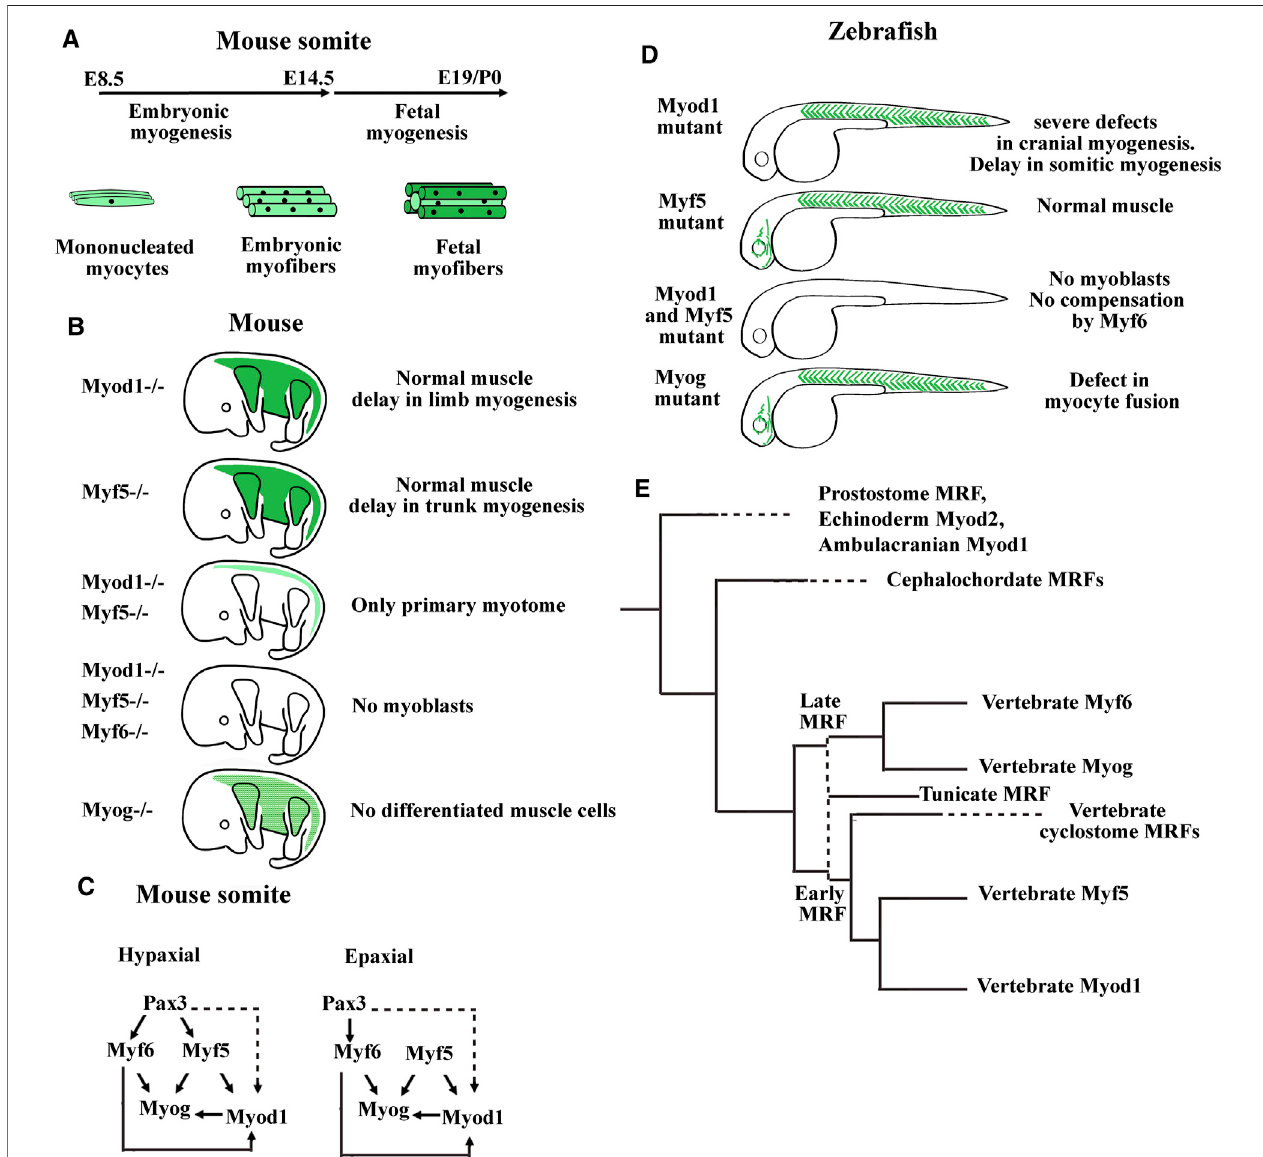
FIGURE 4| Summary ofmyogenic regulatory factor (MRF) functions in mouse and zebra fi sh models. (A) Timing of myo fi bers formation during embryonic and fetal myogenesis in mice. (B) Summary of the main phenotypes of single KO mice for Myod1, Myf5, or Myogenin, double KO mice for Myod and Myf5, and triple KO mice for Myod1, Myf5, and Myf6. Myoblasts formation requires either Myod1 or Myf5. Myog is necessary for muscle differentiation and Myf6 can compensate the absence of Myod1andMyf5onlyduringembryonicmyogenesis.Myf6KOmicedidnotshowmuscledevelopmentdefects.Modi fi edfromHernández-Hernándezetal.(2017). (C) Genetic hierarchy during embryonic myogenesis in epaxial and hypaxial domain of the somite. Mice invalidated for the three genes Pax3, Myf5, and Myf6 show an absence of all skeletal muscles in the trunk indicating that these factors act upstream of Myod1. While the myogenesis in the hypaxial domain is Pax3 dependent, a program initiated by Myf5, Pax3 independent exists in the epaxial domain. Dashed lines indicate that the regulation of Myod1 expression by Pax3 is probably indirect throughPitx2andSixtranscriptionfactors.Headmousemyogenesisisnotpresentedhere.ForamoredetailedanalysisofMRFKOmice,seeBismuthandRelaix(2010), Comai et al. (2014), and Buckingham (2017). (D) Main phenotypes of zebra fi sh single mutants for Myod1, Myf5, or Myog and double mutant for Myod1 and Myf5. The zebra fi shmutantforMyf6didnotshowabnormalmuscledevelopment.Inzebra fi sh,Myod1isnecessaryfornormalcranialmuscledevelopmentwhereasMyf6doesnot compensate the absence of Myod1 and Myf5. (E) Summary of the MRF phylogeny in bilaterians. Aase-Remedios et al. (2020) propose that the four vertebrate genes coding for MRFs do not result from two rounds of whole genome duplication (2R WGD) of a single ancestral gene, that would have taken place between ancestral chordatesandvertebrates.Instead,aclusteroftwoMRFgenesgeneratedbytandemduplicationpredatesthe2RWGD.Onegeneofthisclustergenerates via 2RWGD and gene losses the early vertebrate MRFs (Myf5 and Myod1), and the other generates the late vertebrate MRFs (Myf6 and Myogenin). The fi rst vertical dashed line indicatesthattunicateMRFscouldbetheorthologsofeithertheearlyorthelateancestralMRFgeneprecedingthe2RWGD.ThetwoMRFgenespresentincyclostome species could be the orthologs of the early MRF gene. Cyclostomes would have diverged from gnathostomes after the fi rst R WGD and before the second R WGD (Nakatani et al., 2021). Horizontal dashed lines indicate that the next duplication events in the branch are not shown here. Modi fi ed from Aase-Remedios et al. (2020).